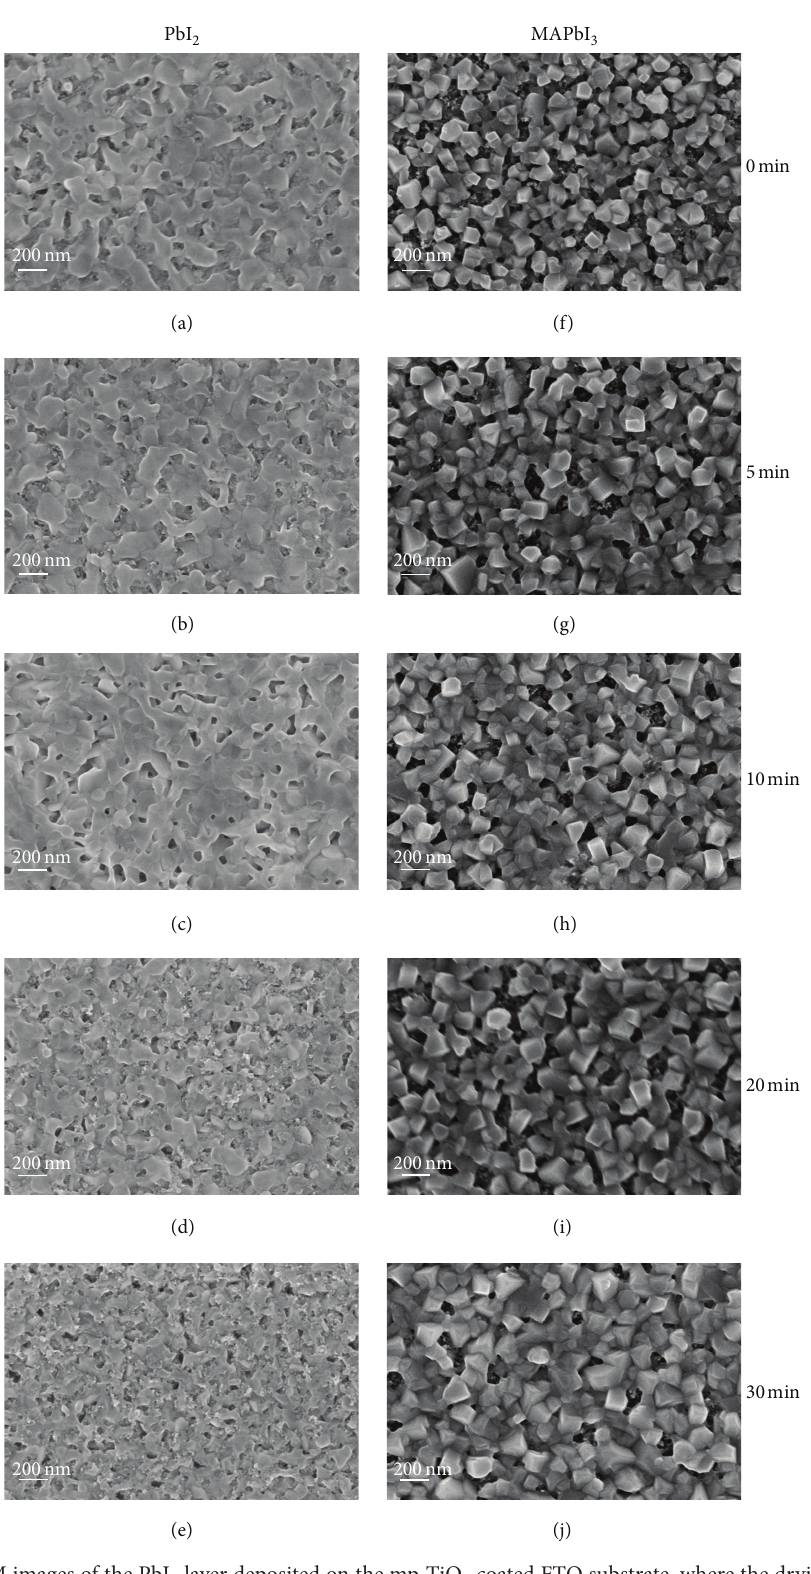
Figure 7: Top-view SEM images of the PbI 2 layer deposited on the mp-TiO 2 coated FTO substrate, where the drying time is for (a) 0 min, (b) 5min, (c) 10min, (d) 20 min, and (e) 30 min. The MAPbI 3 thin film layers correspond to the PbI 2 films (f–j), which were dried at room temperature for different